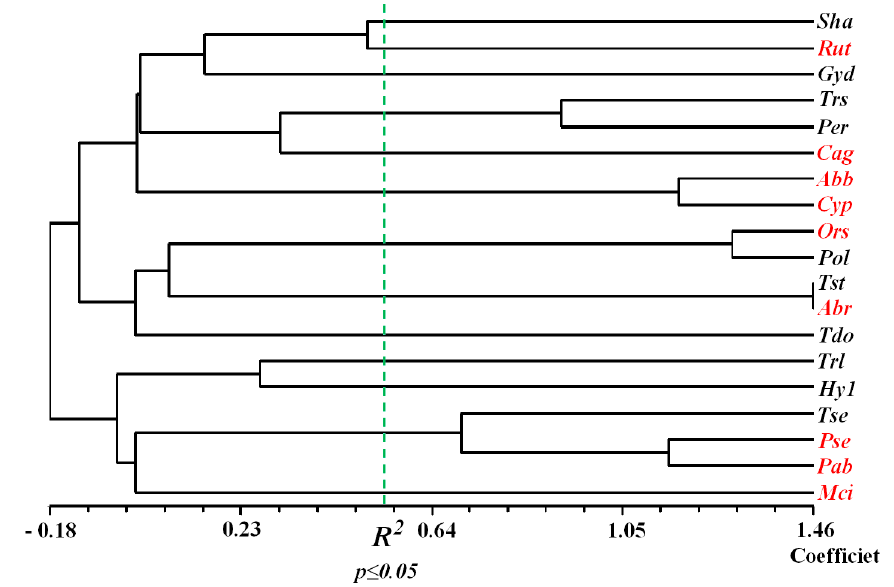
Figure 2. Fish interspecies distribution similarity dendrogram (UPGMA, invariants were excluded). The names of the aboriginal species are shown in black; the introduced species are shown in red. The green line shows a significant positive correlation of pairwise comparison (Trs × Per, Abb × Cyp, etc.).